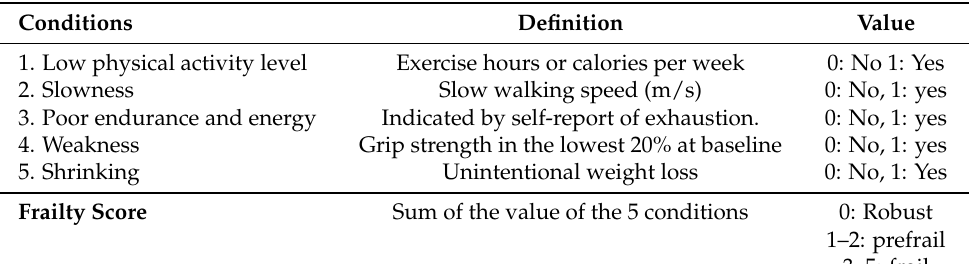
Table 1. Fried’s frailty score and criteria. The five Fried’s conditions, their definitions, and possible values and the frailty score. The table was elaborated from